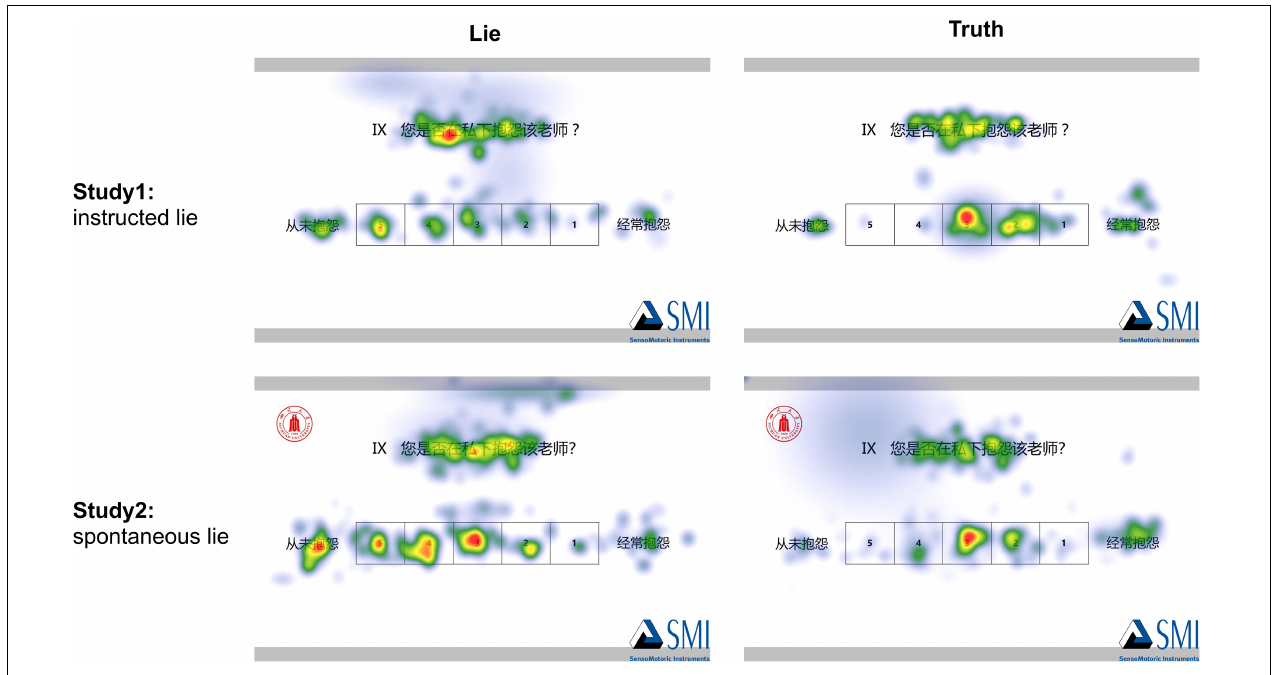
FIGURE 4 | The heat map of lying and honesty in Study 1 and Study